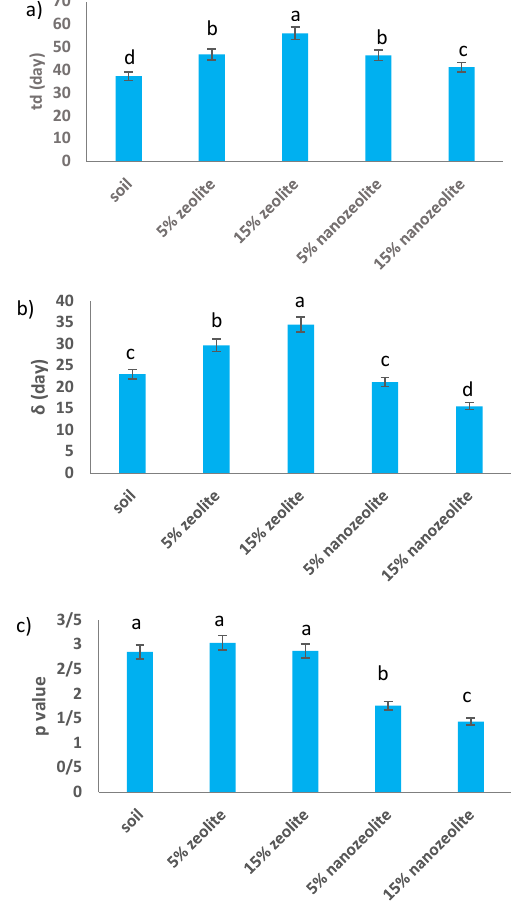
Fig. 5. The Weibull model parameters td (a), δ (b) and p (c) for E. coli NAR survival in the sterile treatments. Bars are ± the standard deviation of means. Means followed by the same letter on the columns indicates no significantly different (P<0.05) by Duncan’s multiple range tests.